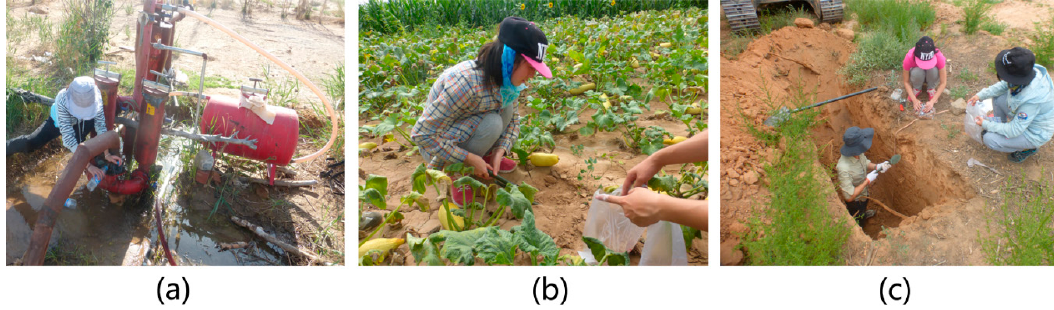
Figure 3. Collection of soil and groundwater samples: ( a ) groundwater samples, ( b ) surface soil samples, and ( c ) profile soil samples. (13 June 2016, by Guoqing Cui).